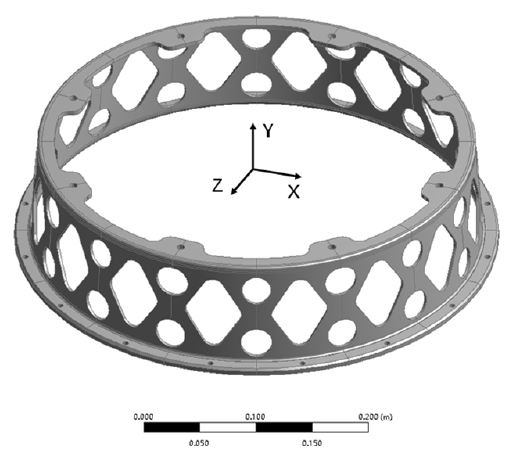
Figure 1. The considered aircraft support, which is a thin-walled structure with several holes and is made of aluminum alloy, weighing 1.60 kg.